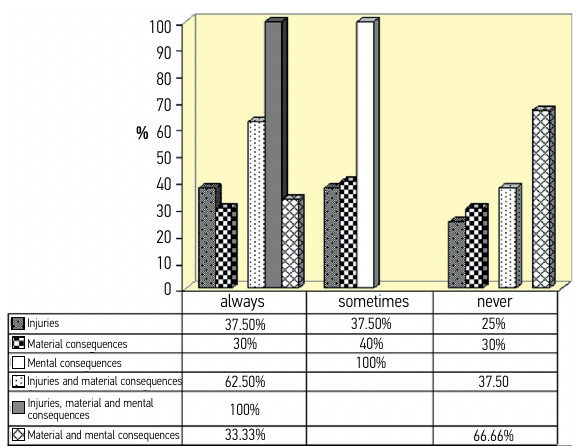
Fig. 8. The frequency of mobile phone use and traffic accidents consequences types